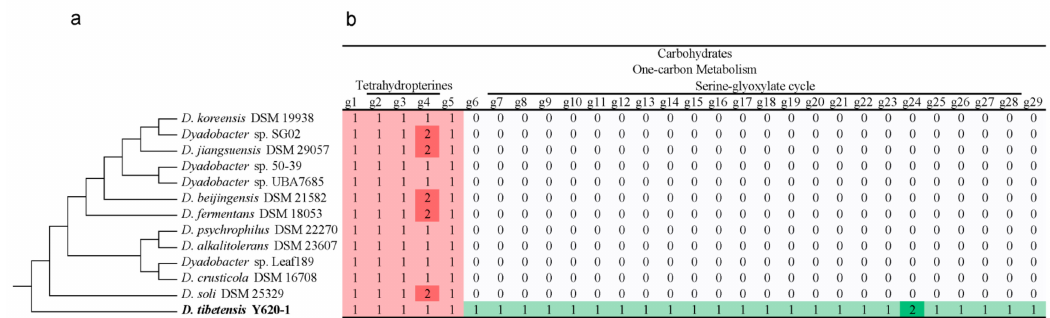
Figure 6. ( a ) Cladogram of Dyadobacter strains based on PhyloPhlAn tree; ( b ) Presence and absence of genes a ffi liated to the RAST category carbohydrates and subcategory one-carbon metabolism, numbers in the boxes represent copies of the related genes. Gene 1-29 represent: Formyltetrahydrofolate deformylase (EC 3.5.1.10), 5-formyltetrahydrofolate cyclo-ligase (EC 6.3.3.2), Methylenetetrahydrofolate dehydrogenase (NADP + ) (EC 1.5.1.5), 5,10-methylenetetrahydrofolate reductase (EC 1.5.1.20), Methenyltetrahydrofolate cyclohydrolase (EC 3.5.4.9), Malate dehydrogenase (EC 1.1.1.37), Serine hydroxymethyltransferase (EC 2.1.2.1), Methylmalonyl-CoA mutase, small subunit (EC 5.4.99.2), Succinate dehydrogenase flavoprotein subunit (EC 1.3.99.1), Aconitate hydratase (EC 4.2.1.3), Succinate dehydrogenase iron-sulfur protein (EC 1.3.99.1), Citrate synthase (si) (EC 2.3.3.1), Propionyl-CoA carboxylase beta chain (EC 6.4.1.3). Methylmalonyl-CoA mutase (EC 5.4.99.2), 5,10-methylenetetrahydrofolate reductase (EC 1.5.1.20), Methenyltetrahydrofolate cyclohydrolase